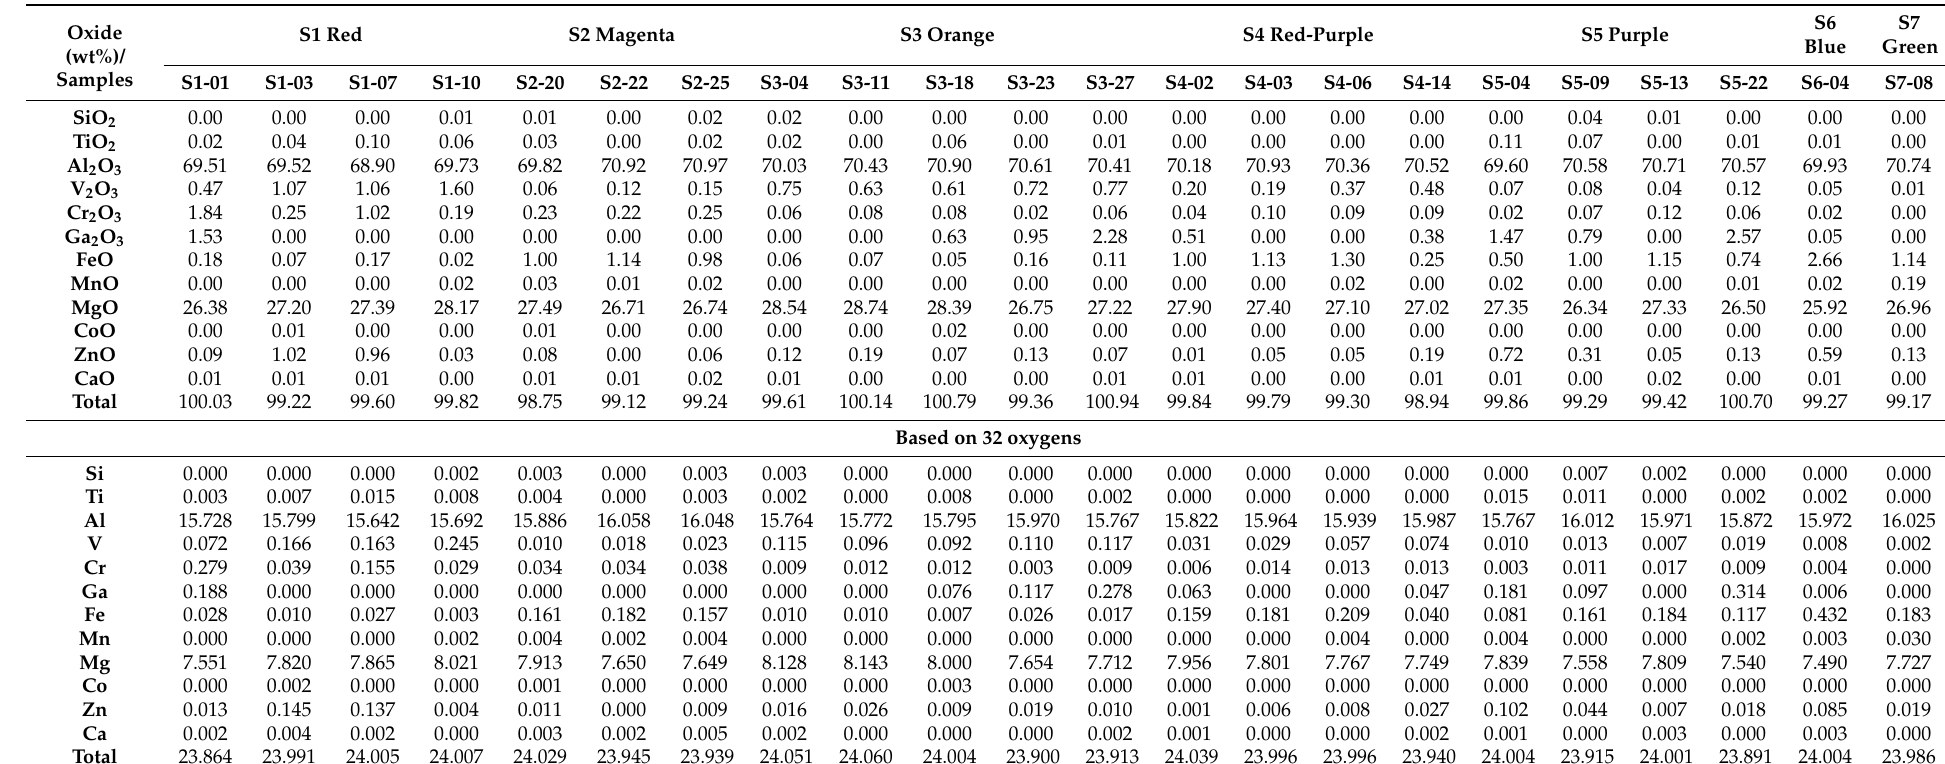
Table 3. Representative EPMA analyses of spinel